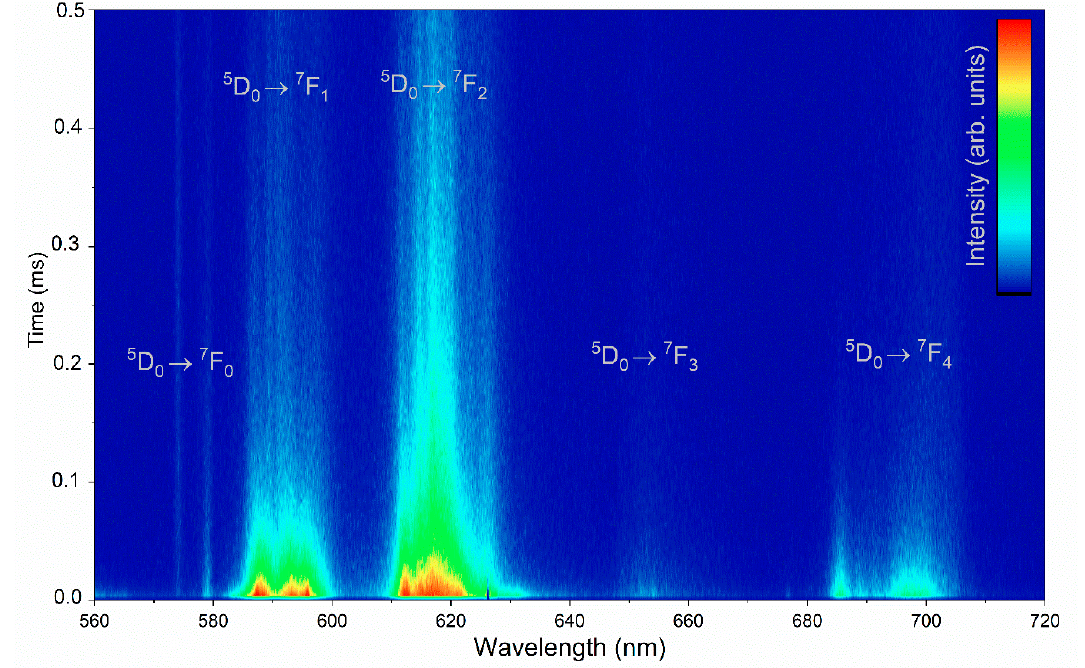
Figure 8. Representative emission spectra map of the 1 mol% Eu 3+ /1 mol% Cu 2+ :Ca 10 (PO 4 ) 6 (OH) 2 .